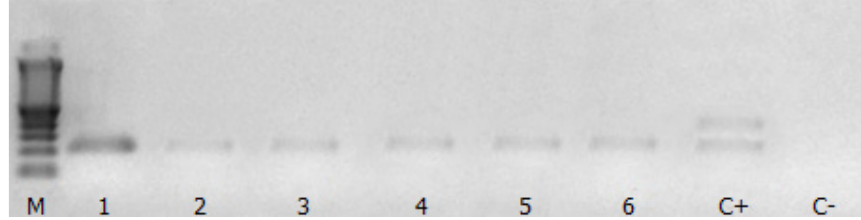
Fig 1 . Agarose gel (2%) showing duplex PCR products ( Nosema apis / Nosema ceranae ). M: Marker. 1-6: Samples infected with Nosema ceranae . C +: Positive control of Nosema apis (321bp) and Nosema ceranae (218bp). C-: Negative control.